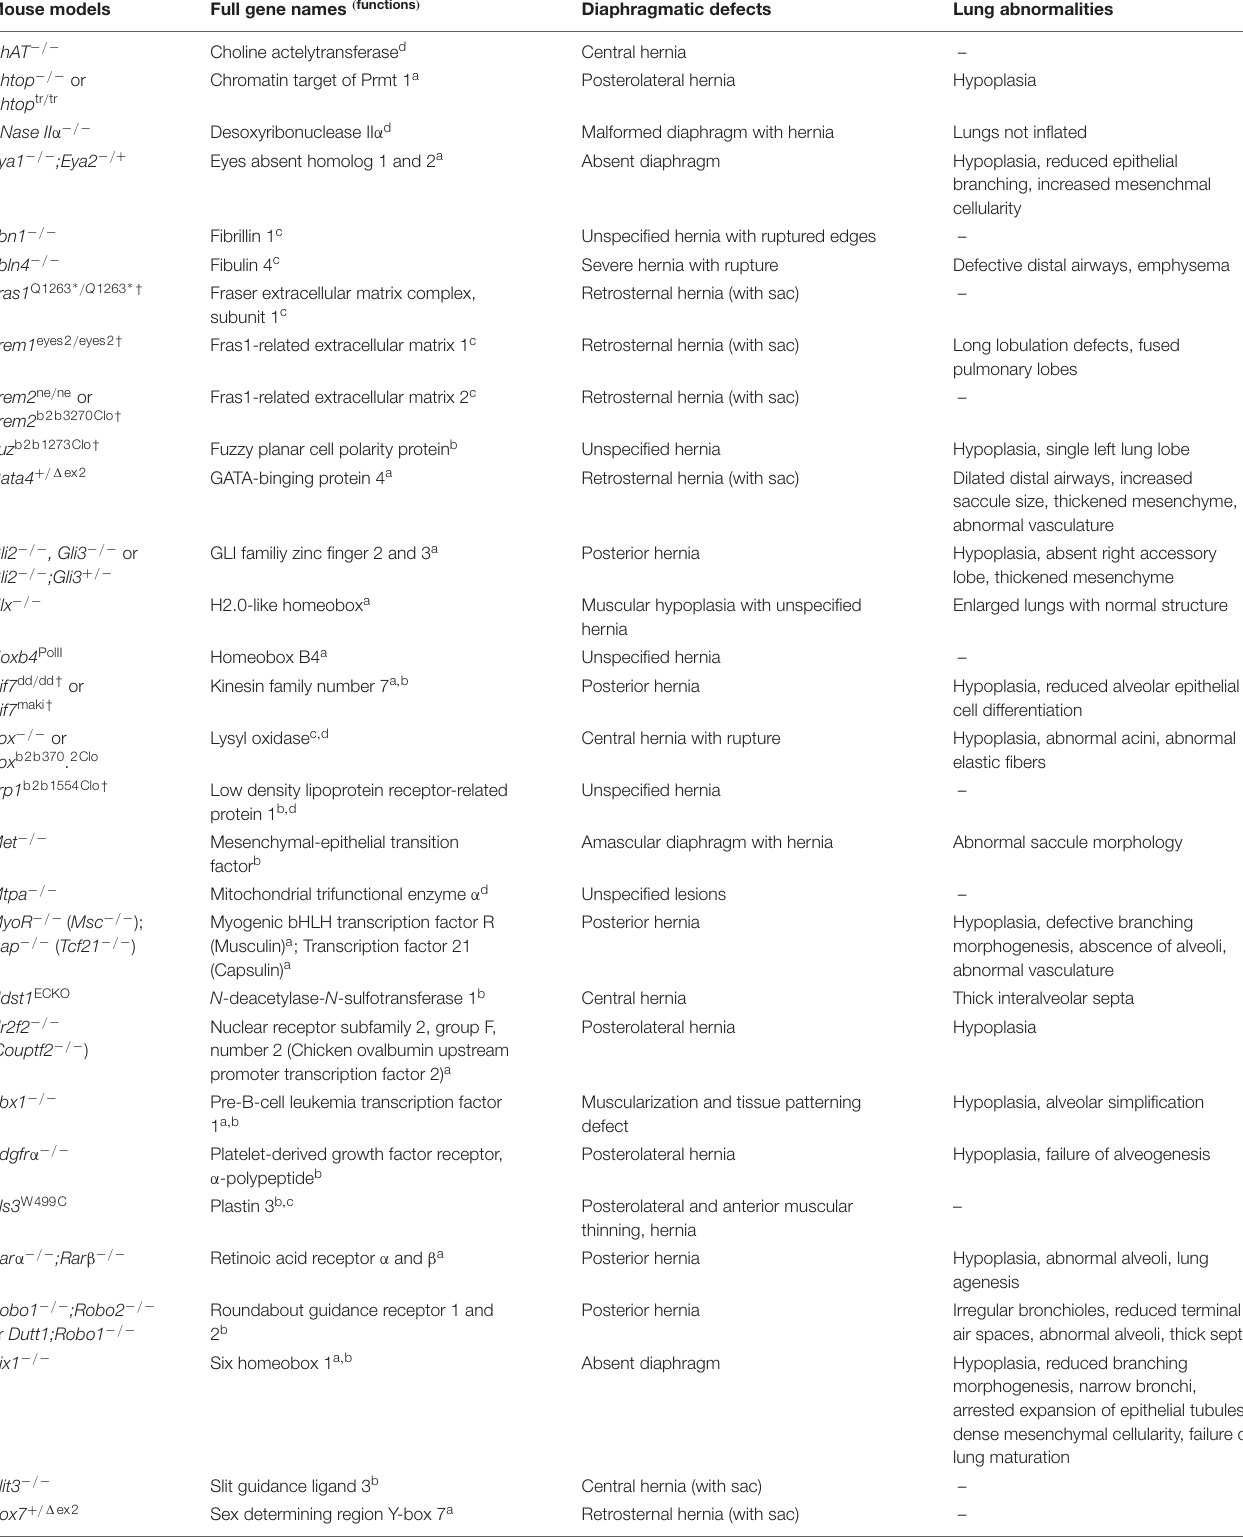
TABLE 1 | Genetically modified mouse models of congenital diaphragmatic hernia. Mouse